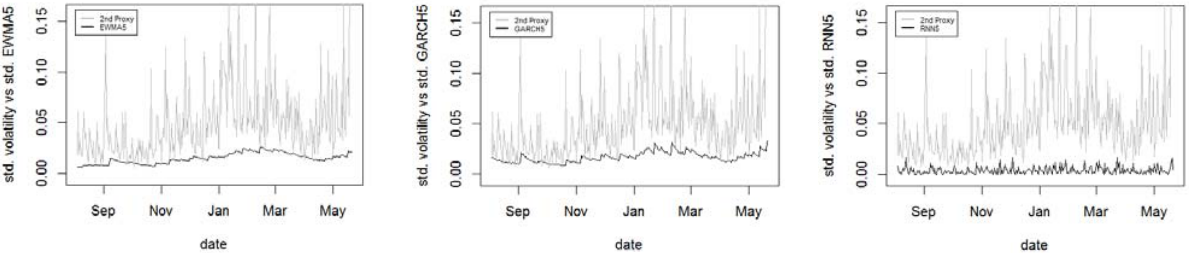
Figure A2. Out of sample standard deviation of realized volatility (2nd proxy) vs. standard deviation of 5 days ahead volatility forecasting of EWMA, GARCH and RNN model